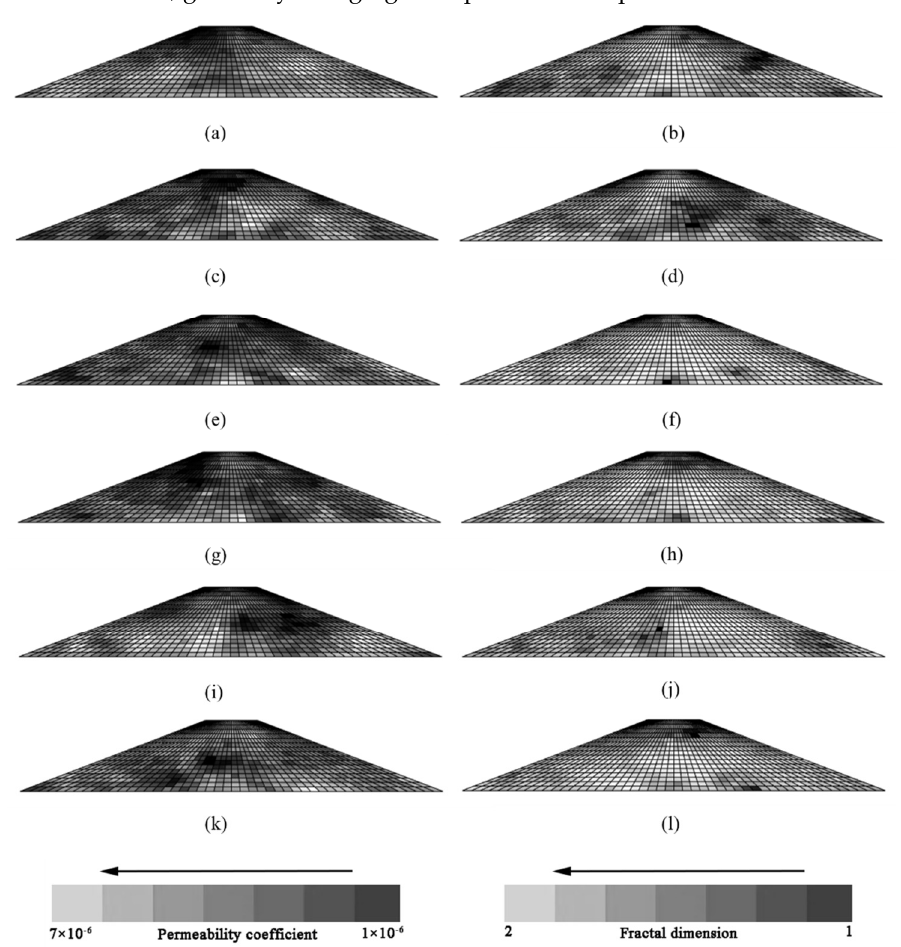
Figure 4. Distribution of hydraulic conductivity ( k ) and fractal dimension ( D ) of sections 1 − 6 in the embankment: ( a ) k in section 1; ( b ) D in section 1; ( c ) k in section 2; ( d ) D in section 2; ( e ) k in section 3; ( f ) D in section 3; ( g ) k in section 4; ( h ) D in section 4; ( i ) k in section 5; ( j ) D in section 5; ( k ) k in section 6; ( l ) D in section